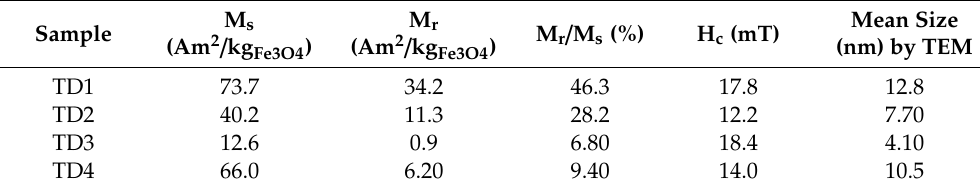
Table 4. The magnetic features of samples TD1–TD4. M s represents the scaled saturation magnetization, M r the scaled remanence magnetization, and H C coercivity. The M s values decrease gradually with the mean